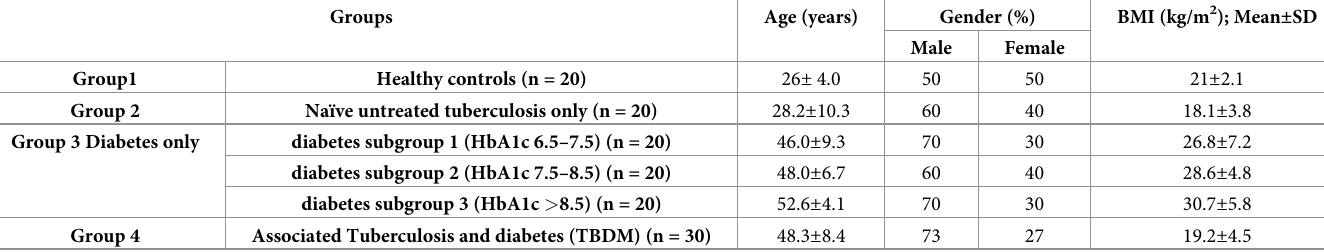
Table 2. Demographic and anthropometric characteristics of study samples of different groups. Groups